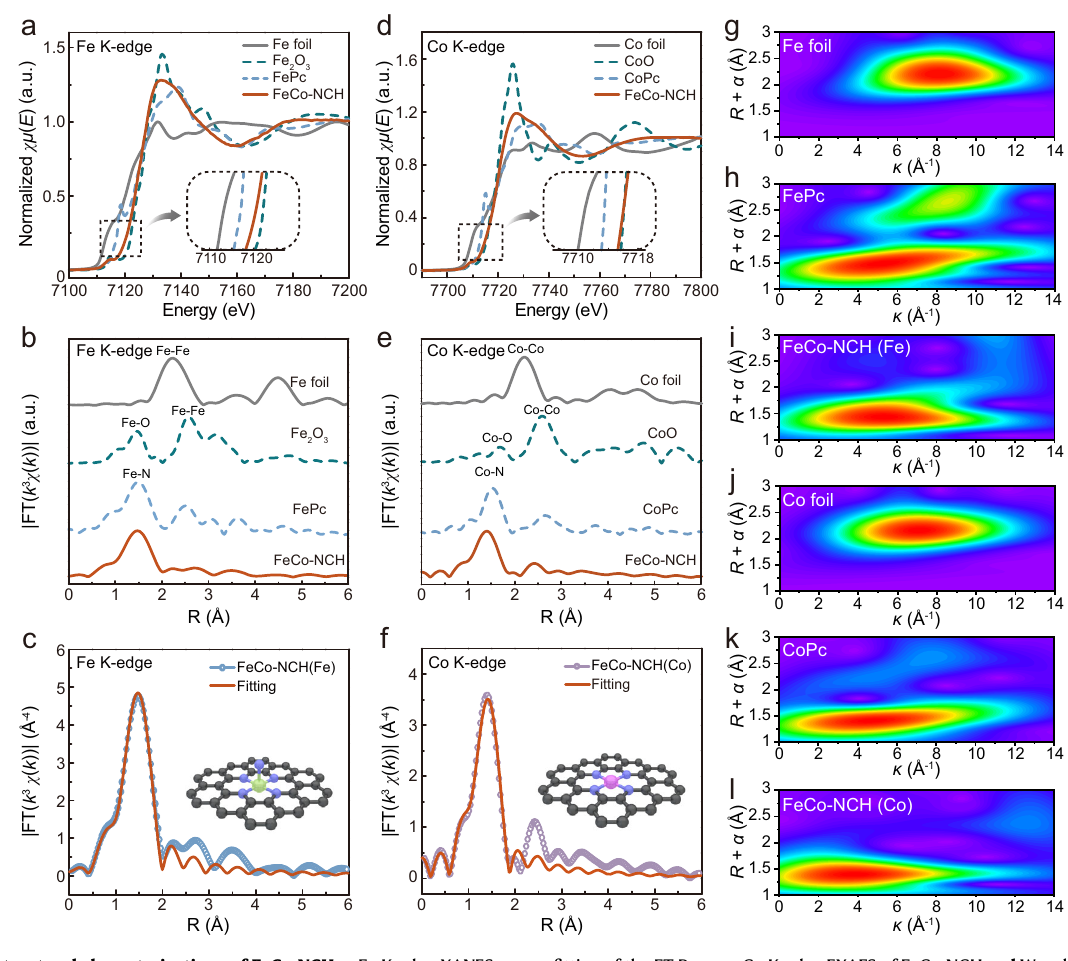
Fig. 3 | Local structural characterizations of FeCo-NCH. a Fe K-edge XANES spectra and b Fourier-transform (FT) EXAFS spectra of FeCo-NCH and reference samples. c The fi ttingoftheFTR-spaceFeK-edgeEXAFSofFeCo-NCH. d CoK-edge XANES spectra and e FT EXAFS spectra of FeCo-NCH and reference samples. f The